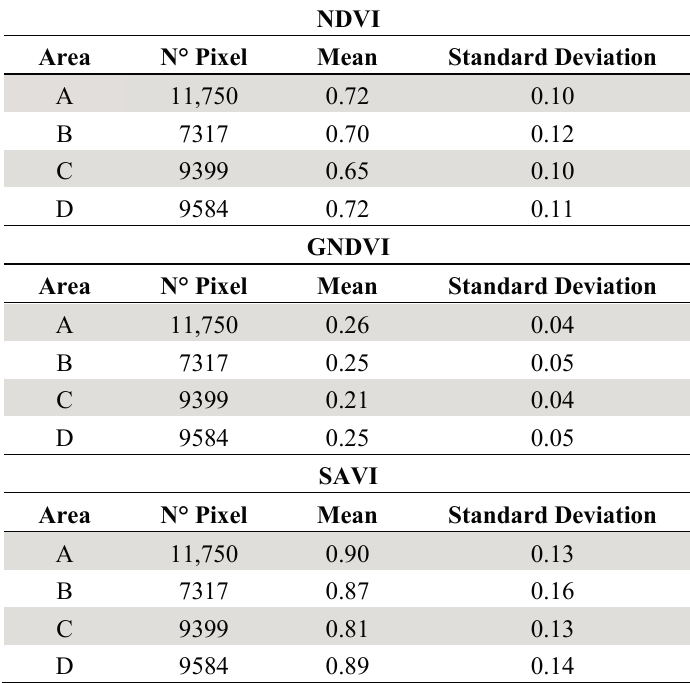
Figure 10. The manually digitized vineyard lines for the areas under investigation (A, B, C, D) to compute the VI only inside the cultivated zones and eliminate possible spectral disturbs from ground vegetation, wood, shadows, etc. Table 6. Mean and Standard Deviation of sample areas A, B, C, and